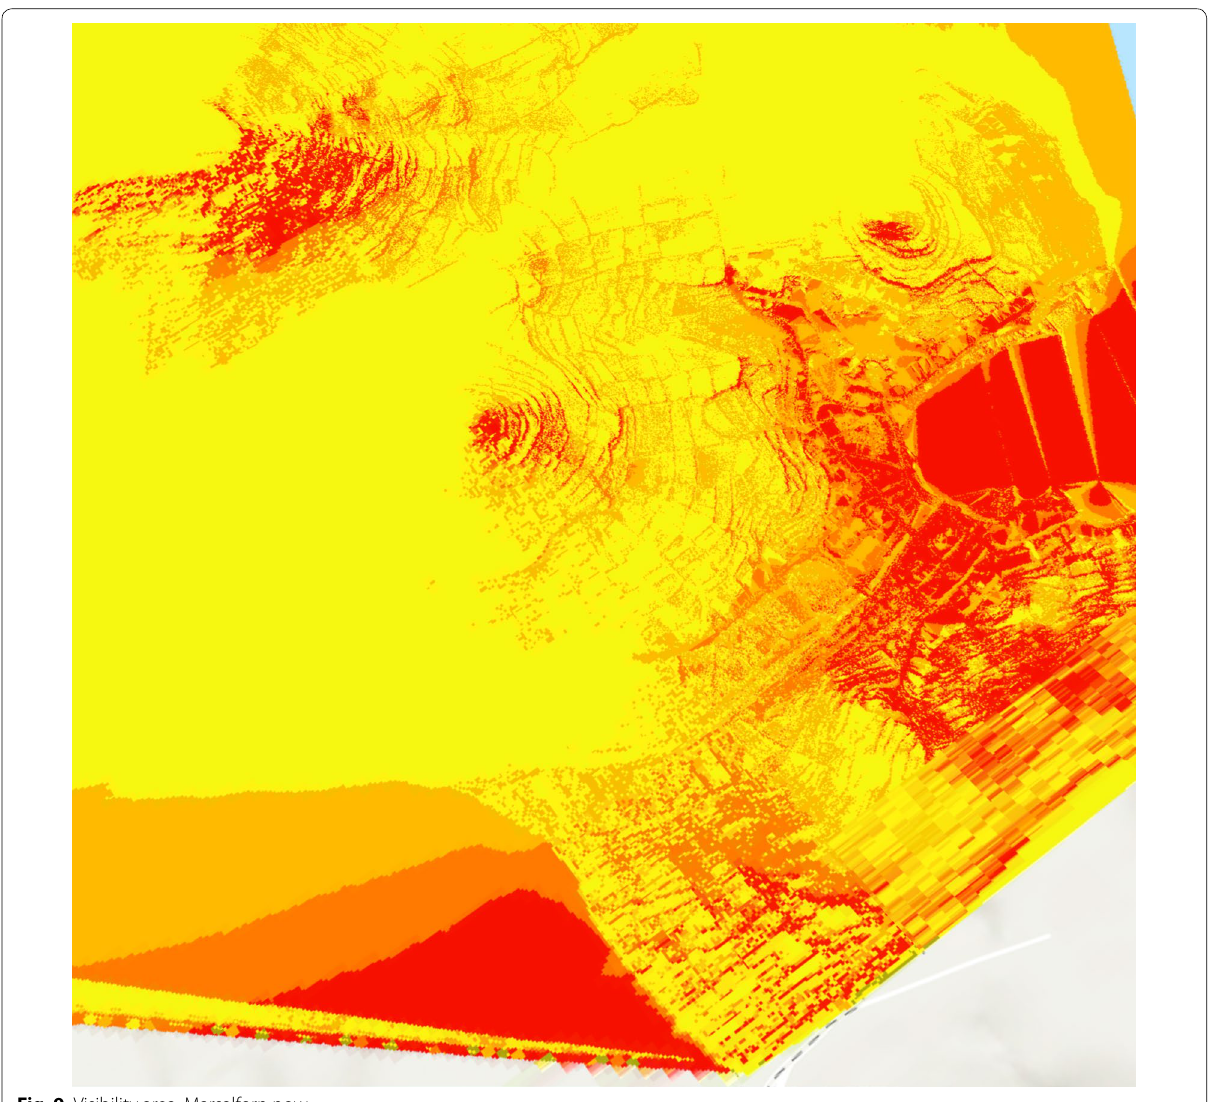
Fig. 9 Visibility area. Marsalforn